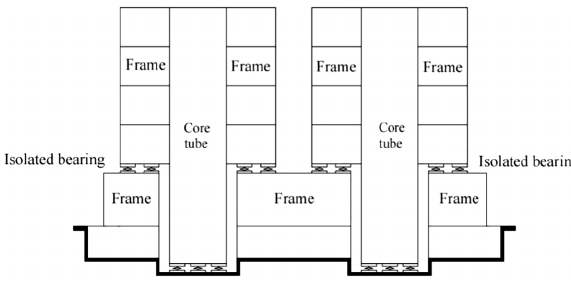
effectsa) Figure 4. Model diagram of the new staggered story isolated structure: a – considering SSI effect; b – not considering SSI